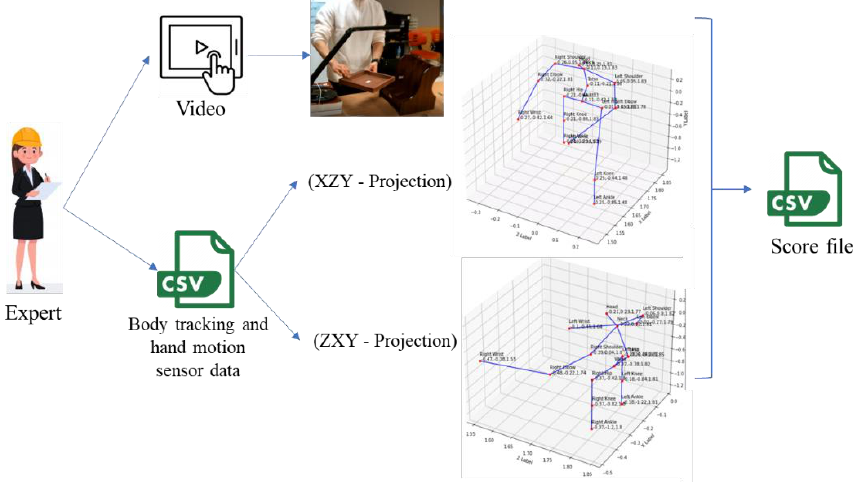
Figure 2. Annotation used by the expert.